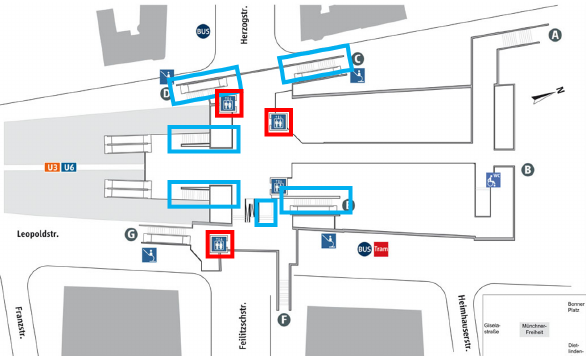
Figure 15. Landmark position in the Münchner Freiheit underground station. The blue rectangles indicate the position of staircases. The red rectangles indicate the position of